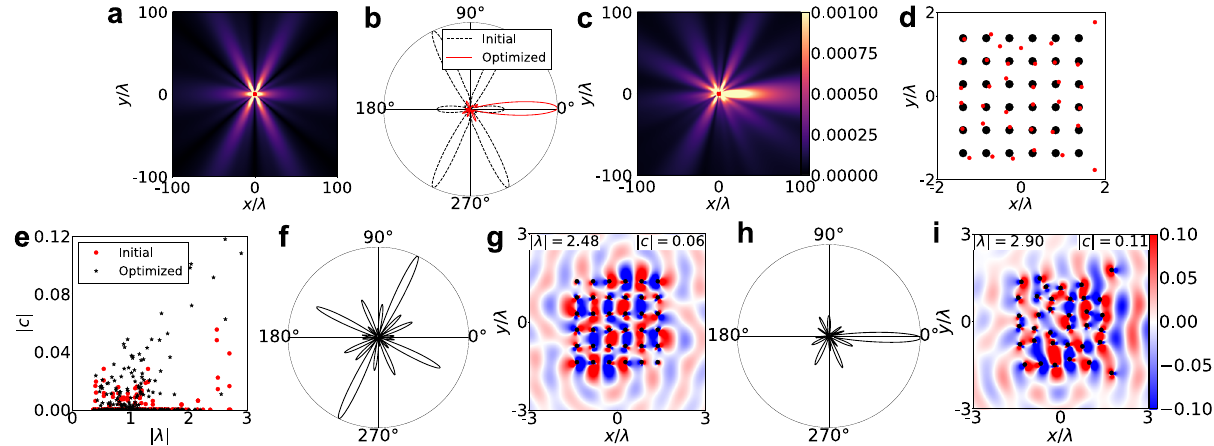
Fig. 4 Re-structuring the far- fi eld of a dipole emitter to radiated power in a particular direction. ( a ) shows ∣ E ∣ for the initial con fi guration (regular array), viewed from the far- fi eld. ( b ) shows a comparison of the far- fi eld distribution of the Poynting vector for the initial con fi guration (black dashed line) and the optimised con fi guration (red line). All far- fi eld distributions are normalised to have unit amplitude. The width of the beam in the optimised structure is ~20°. ( c ) shows ∣ E ∣ of the optimised structure, viewed from the far- fi eld. The initial and fi nal scatterer locations are shown in ( d ), and the change in eigenmodes and their expansion coef fi cients over the optimisation are shown in ( e ). The evolution of the properties of the eigenmode with the largest expansion coef fi cient is shown in ( f – i ). Both the distribution of E y in the plane of the scatterers and the normalised far- fi eld Poynting vector are shown. ( f – g ) show the mode with the largest expansion coef fi cient in the initial strucutre, with ( h – i ) showing the mode with the largest expansion coef fi cient in the fi nal structure. It is clear that the mode shown in ( h – i ) is responsible for the strong directivity along θ = 0° in the optimised